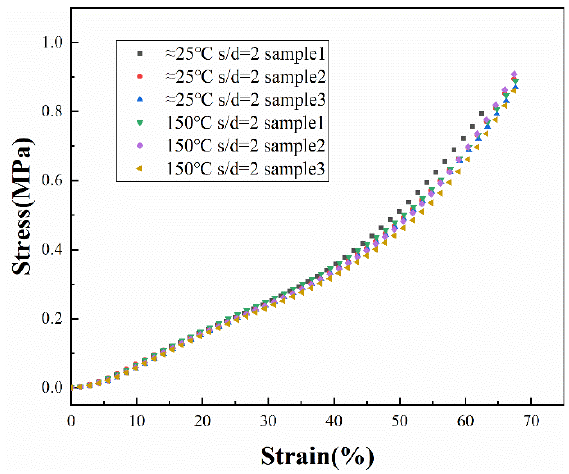
Figure 14. Stress–strain profiles of s/d = 2 samples. Figure 14. Stress – strain profiles of s/d = 2 samples. Figure 14. Stress – strain profiles of s/d = 2 samples.